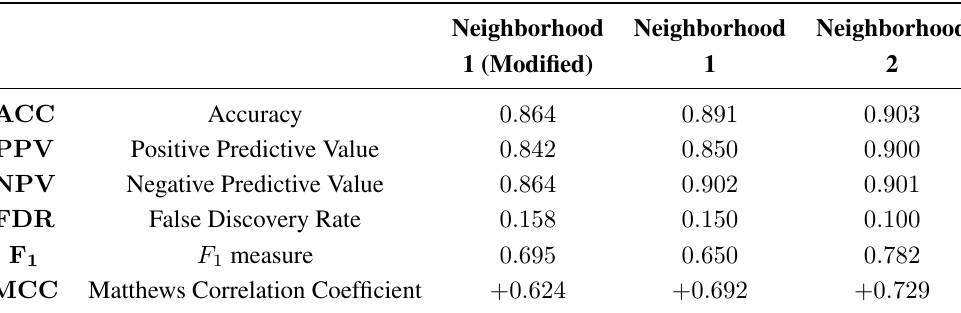
Table 3. Change detection